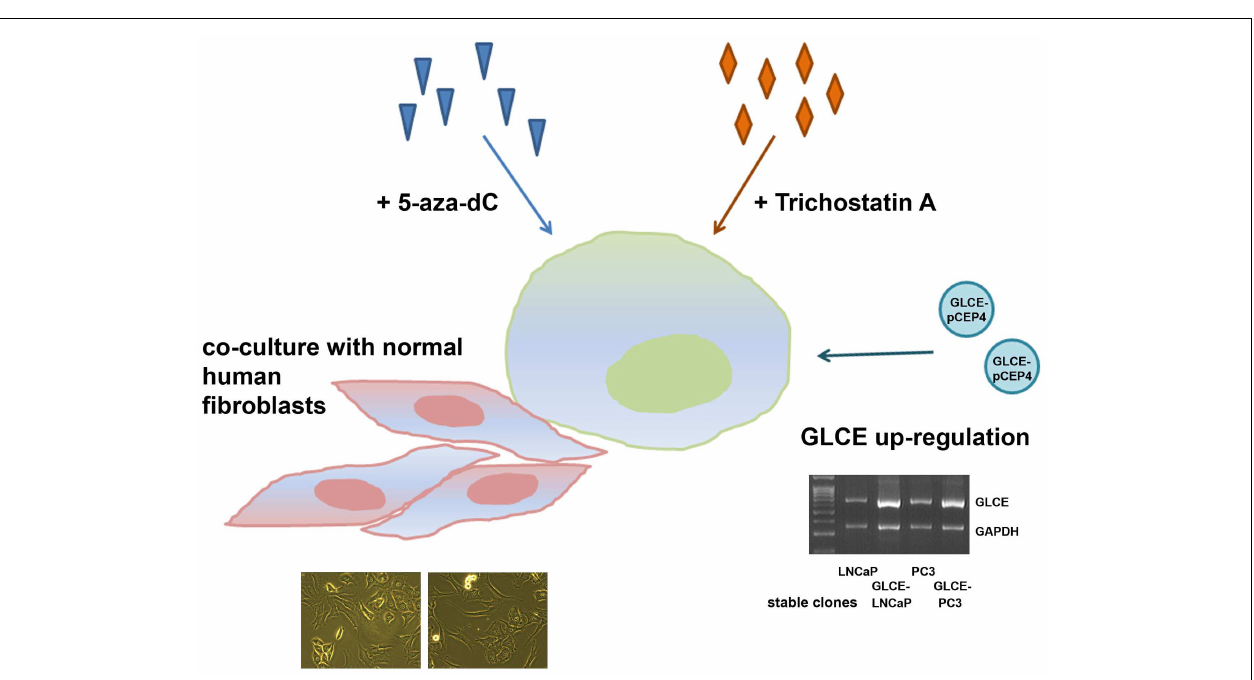
5-aza-dC – 5-deoxyazacytidine, multiplex RT-PCR gel showing GLCE expression in LNCaP and PC3 cells stably transfected with the pCEP4